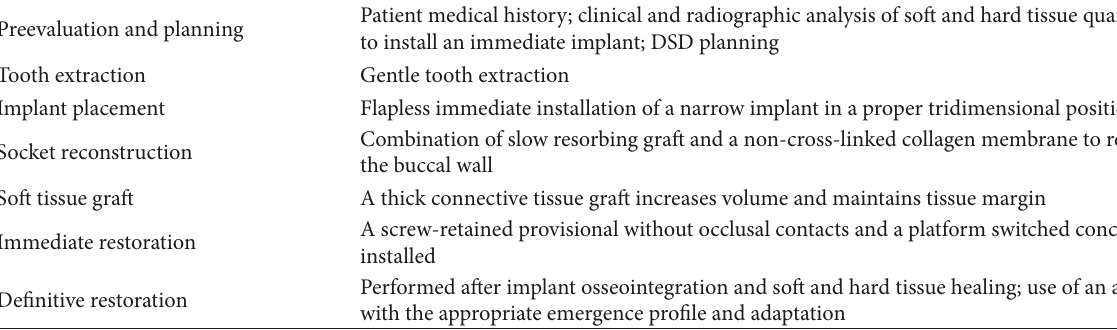
Table 1: An appropriate protocol is used to perform immediate tooth replacement in sockets with a buccal wall